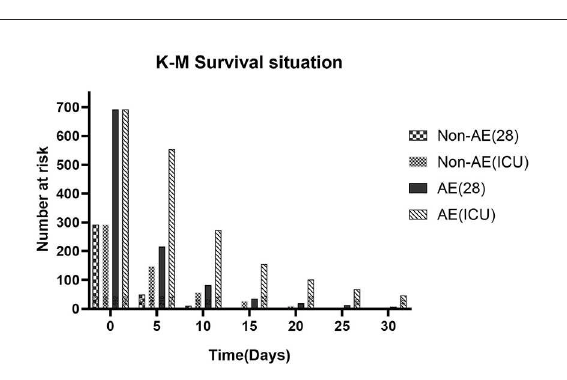
FIGURE2 K–M survival situation about AE-device therapy and outcomes at different times.